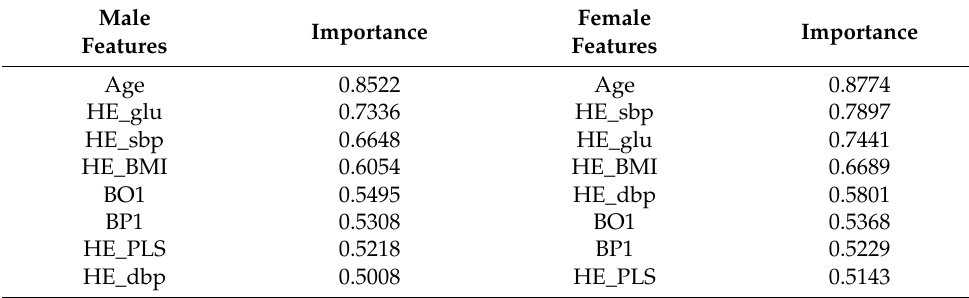
Table 6. Features’ importance according to gender.